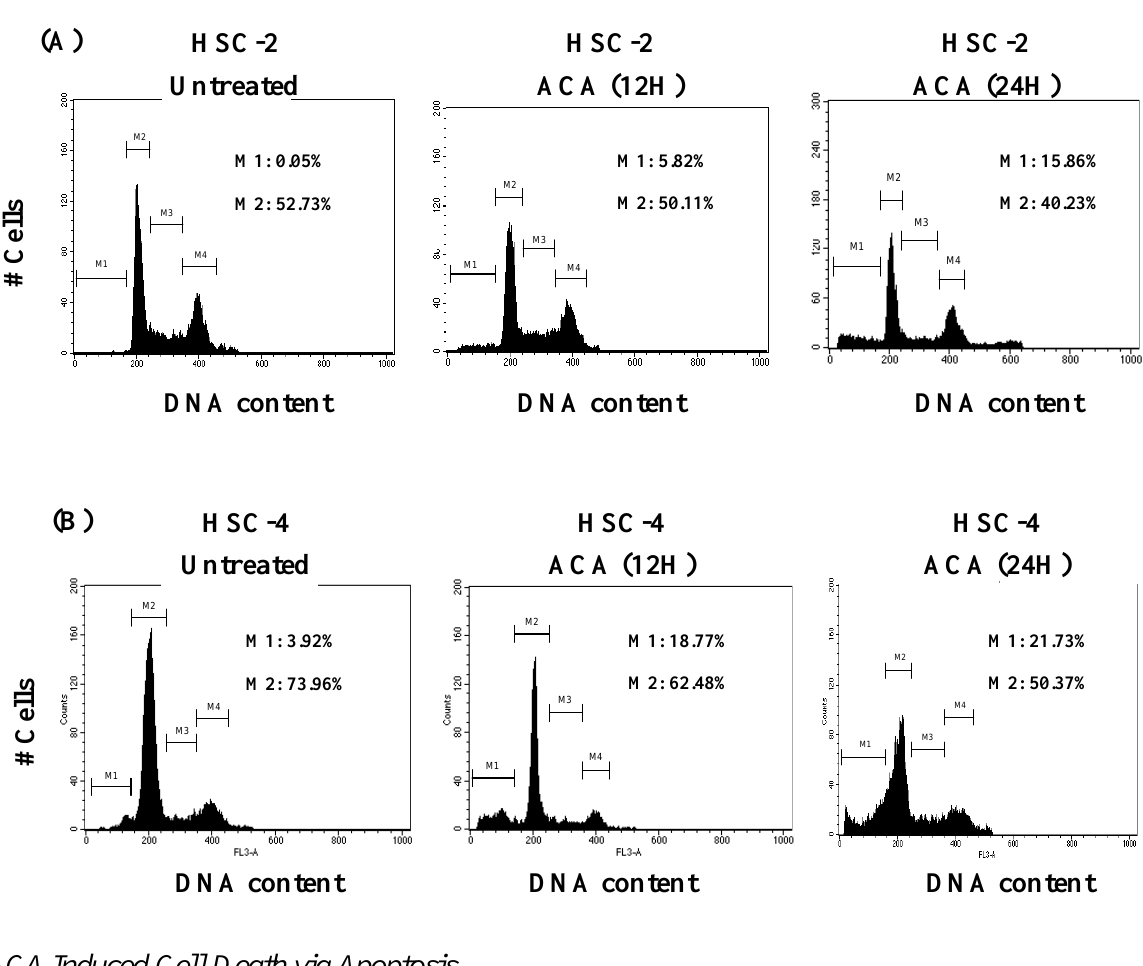
Figure 4. Cell cycle distribution of cancer cell lines using flow cytometry after staining with PI. (A) HSC-2 cells treated with ACA; (B) HSC-4 cells treated with ACA. M1: Sub-G phase; M2:G /G phase; M3:S phase; M4:G 1 0 1 representative of 10,000 cells and the percentage of cells in all cell cycle phases are